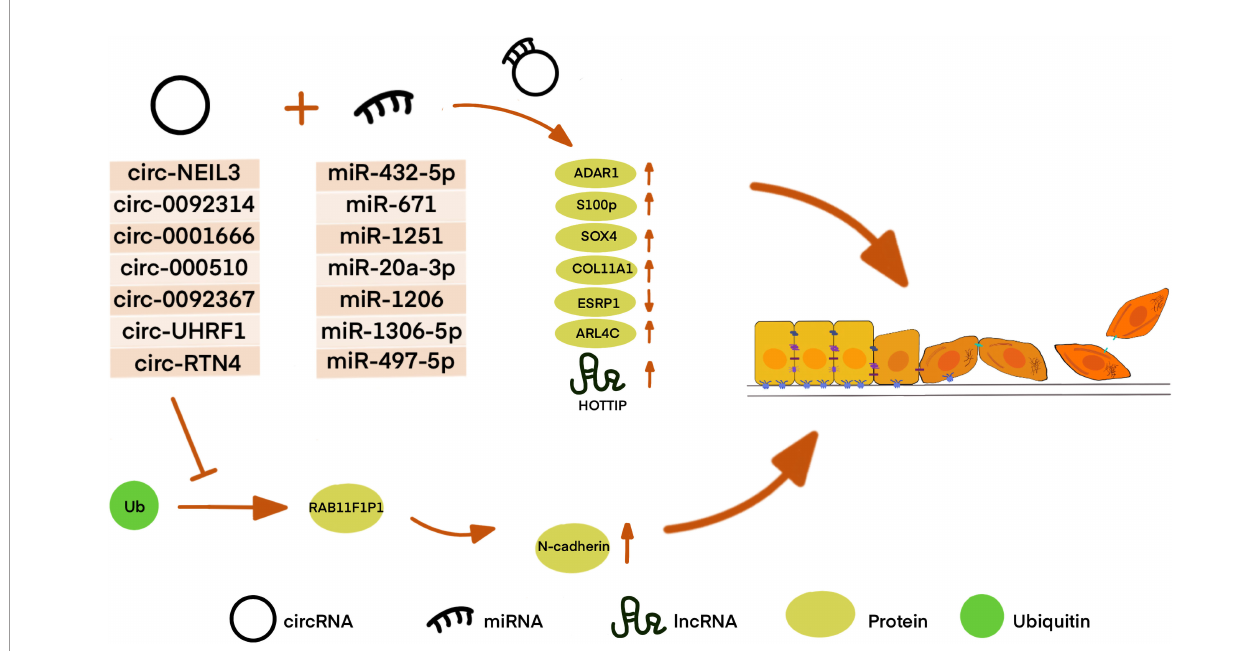
FIGURE 3 | CircRNA affects EMT in many different ways in PDAC. Most CircRNAs can bind to miRNA as a sponge to regulate downstream protein or lncRNA. Circ- RTN4 is also found to regulate protein by hindering protein ubiquitination and degradation as well as acting as ceRNA.